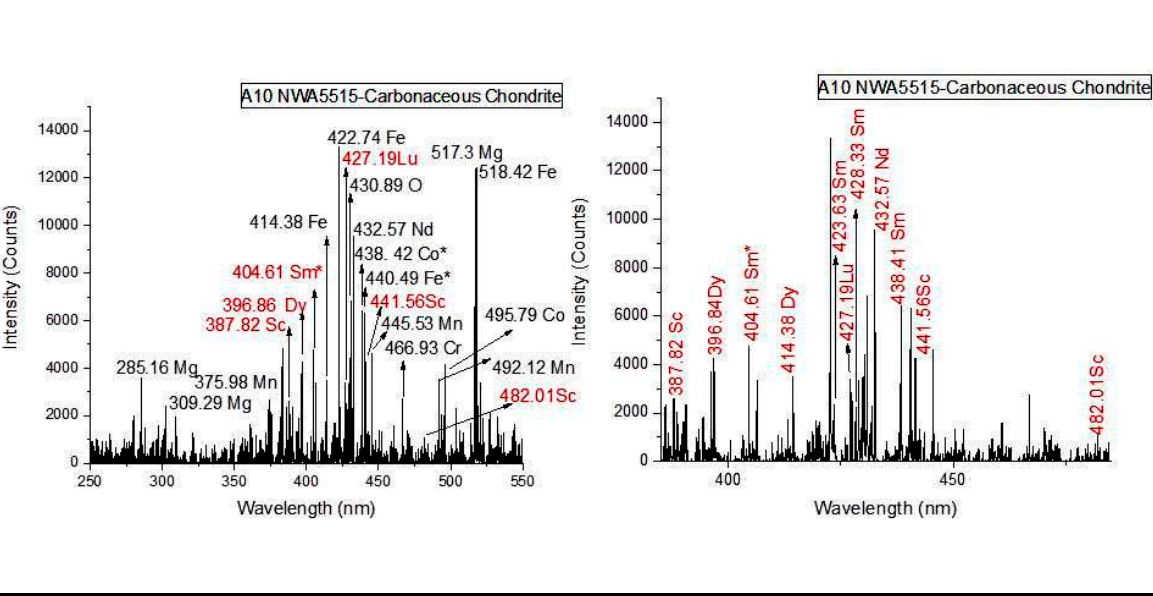
Figure 12. LIBS spectrum recorded for Sample A10 and selected range (380–500 nm) to identify REEs. In the case of Sample A2 (Mars rock), the characteristic iron lines were observed at 422.78 nm, 430.90 nm and 396.87 nm, and the decisive lines of oxygen were observed at 430.28 nm and 404.61 nm. The magnesium line can be observed at 442.31 nm. In addition, aluminium line was observed at 394.47 nm and 393.35 nm. In addition to these, lines corresponding to the minor components were observed at 526.55 nm and 445.47 nm for calcium and at 438.41 nm for sodium. However, there was no line indicative of the presence of